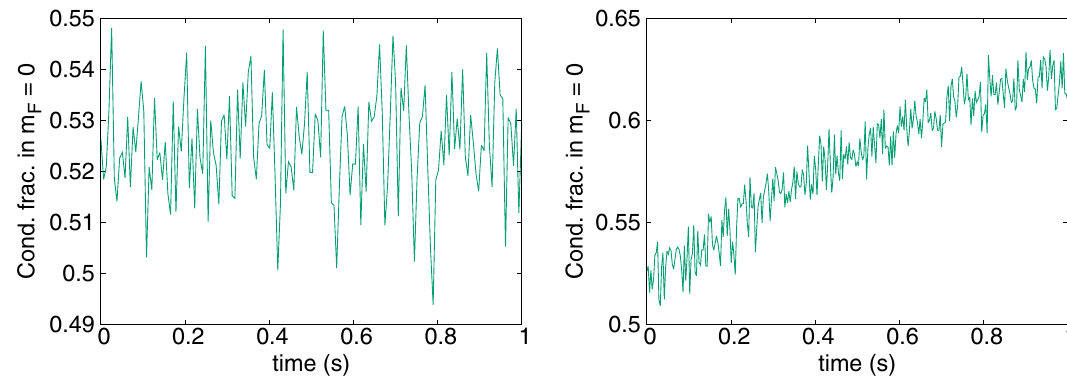
0 component as a function of time for a high Zeeman Figure 10. Condensate fraction of 23 Na in the m F = 4.25 G). This value corresponds to the thermal energy of the system k B T . The initial 20 (cid:31) ω x (B energy of q = = 0 (left) and M 0.2 magnetization of the system is M = =